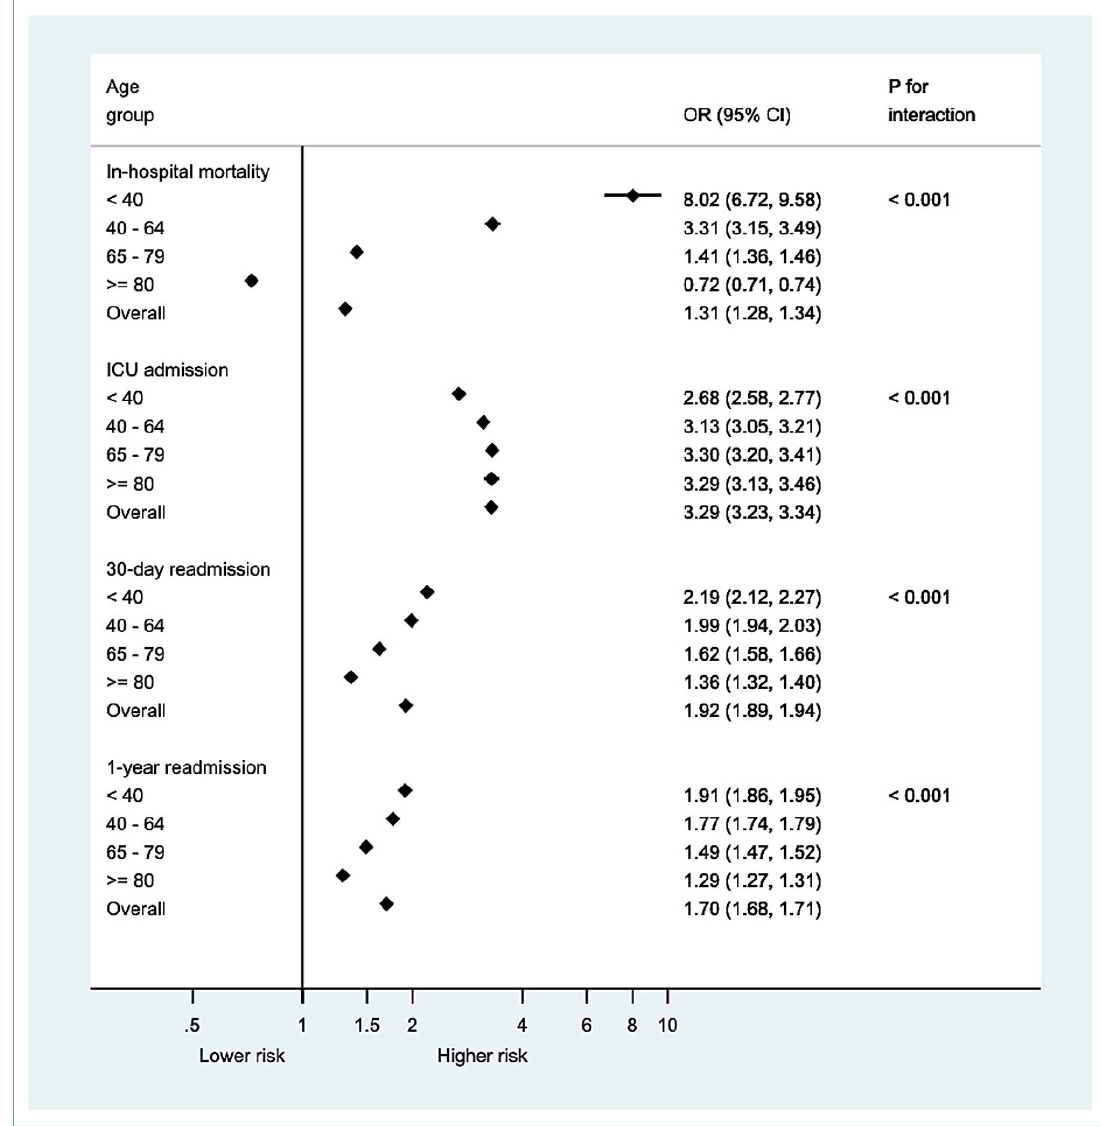
Figure 3: Odds ratios of primary and secondary outcomes, applicable for multimorbid cases, non-multimorbid cases served as reference. CI = confidence interval; OR = odds